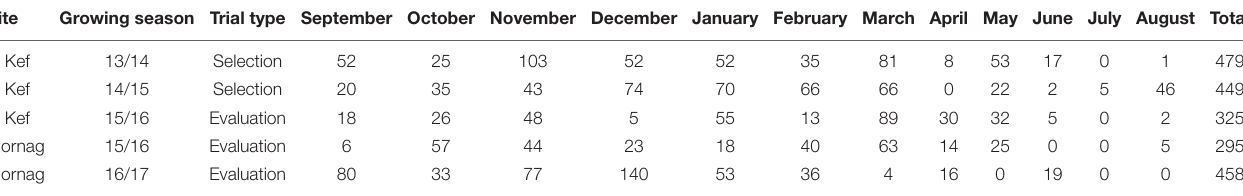
TABLE 2 | Monthly precipitation at the two experimental sites for the growing seasons of selection and evaluation trials.